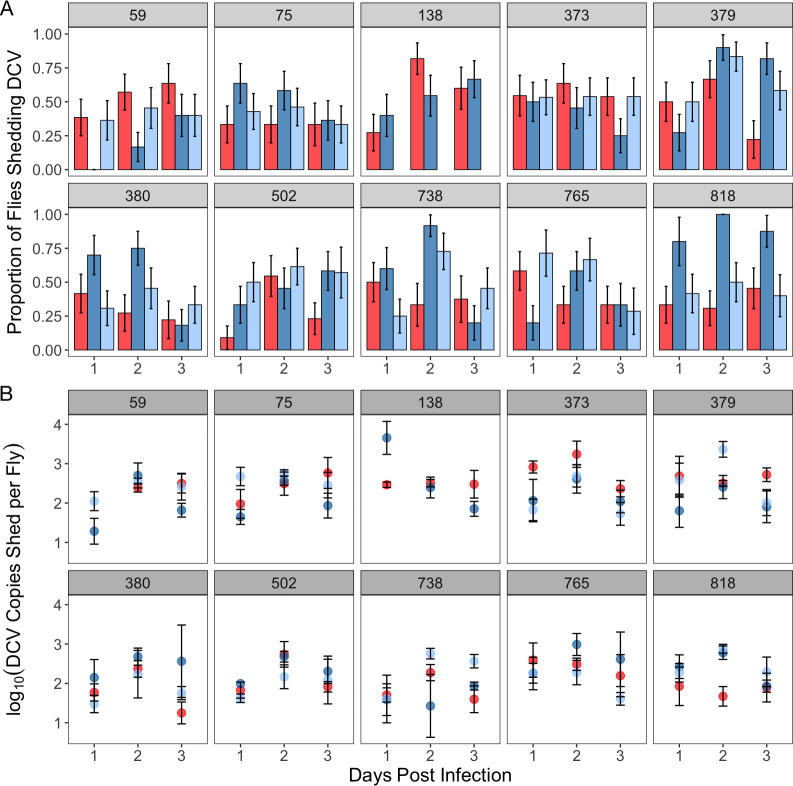
Mean±SE (a) proportion of flies shedding non-zero titres of DCV and the (b) titre of the non-zero virus shedding subset over the first 3 days of infection. Panels denote genetic background, while the colour of bars, points and lines represent sex and mating status. Males are shown in red, mated females in blue, and virgin females in pale blue. Bars of the same colour in each in pane in panel (a) represent (from left to right) days 1, 2 and 3 of infection.